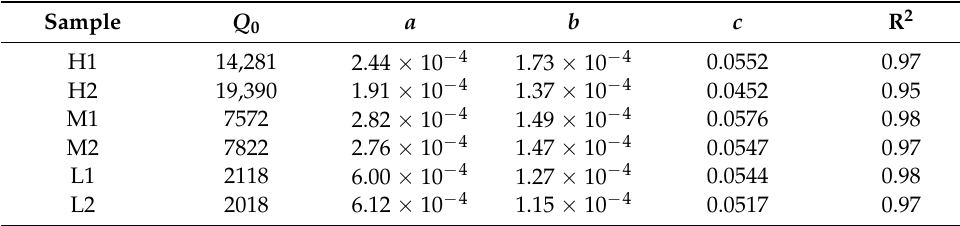
Table 6. Parameter values of Q-factor degradation fitting curve baking at 85 ◦ C.